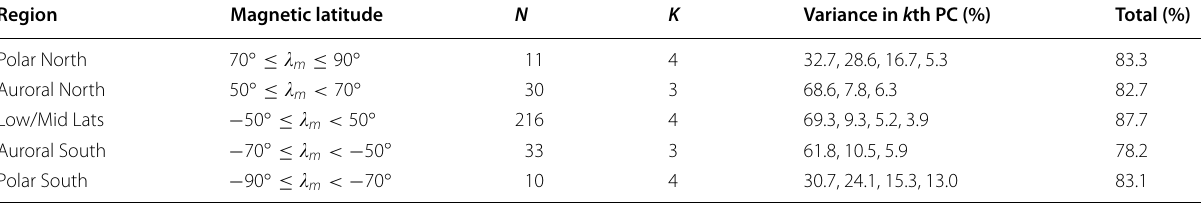
Table 1 Magnetic latitude boundaries for each of the five regions de-noised separately using PCA Region Magnetic latitude N Polar North Auroral North Auroral South Polar The number ( N ) of GVOs per region, the number ( K ) of PCs removed during each analysis, the percentage variance accounted for by each of the K PCs and the total percentage variance removed